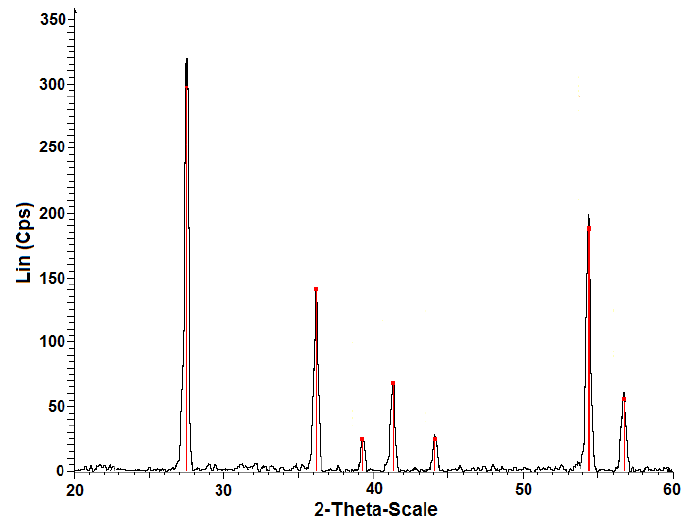
nanoparticles prepared at 70°C and dried at 120°C for Fig. 3: XRD pattern of TiO 2